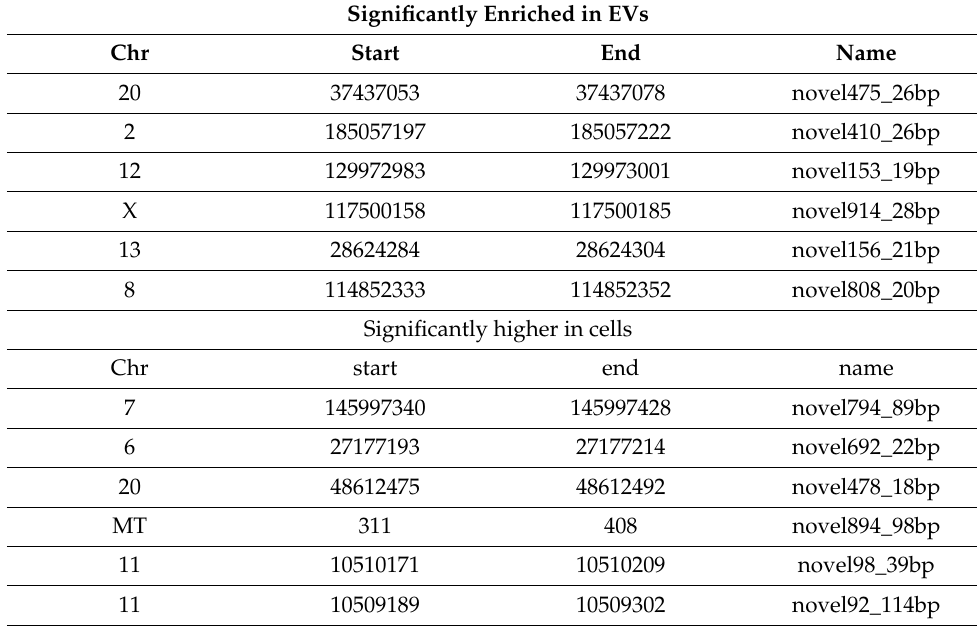
Table 4. The novel (unannotated) transcripts that were significantly different between the cells, and the EVs chromosomal